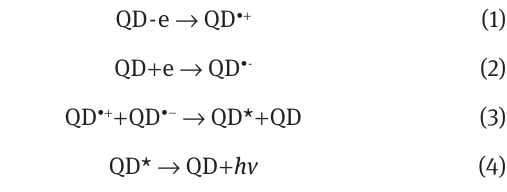
Cl containing 0.1 m TBAP. The lines are 2 2